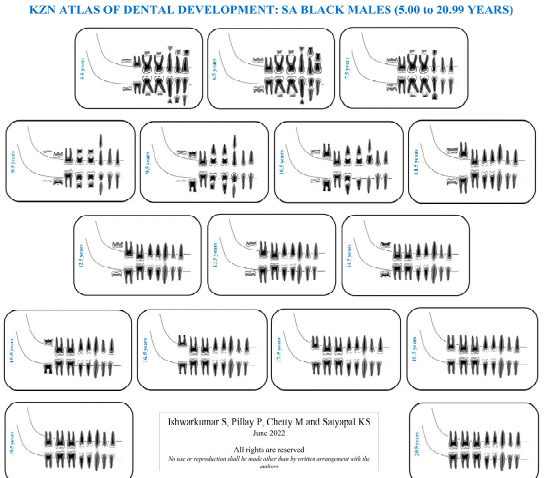
Figure 1. KZN Atlas of dental development for South African Black female.